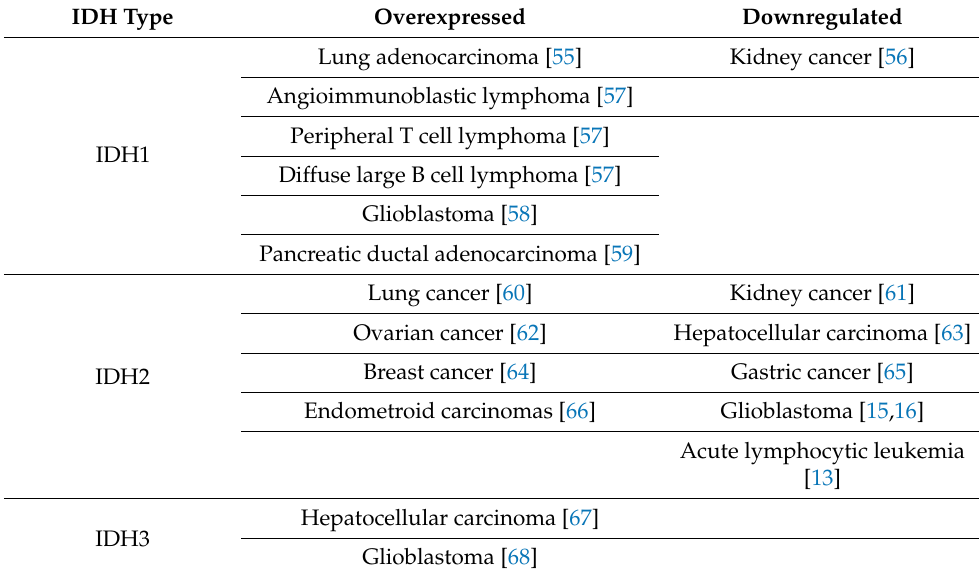
Table 1. The expression of wild-type IDHs in cancers. The expression levels of IDHs in tumors not listed in the table but mentioned in the text have not been clearly